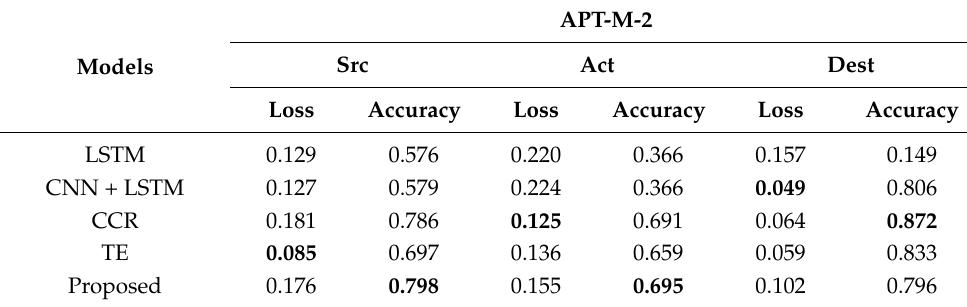
Table 4. Performance based on APT-M-2 and evolving graph.